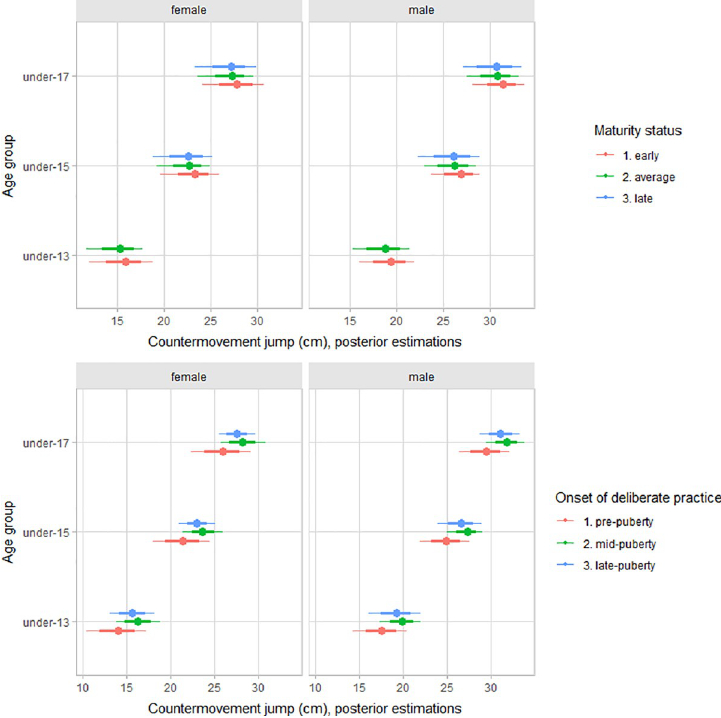
Fig 2. Posterior estimations and uncertainty (bold lines and thick ones represent 67% and 90% intervals, respectively) for countermovement jump performance by age group and contrasting age group by maturity status (upper plot), and the onset of deliberate practice (lower